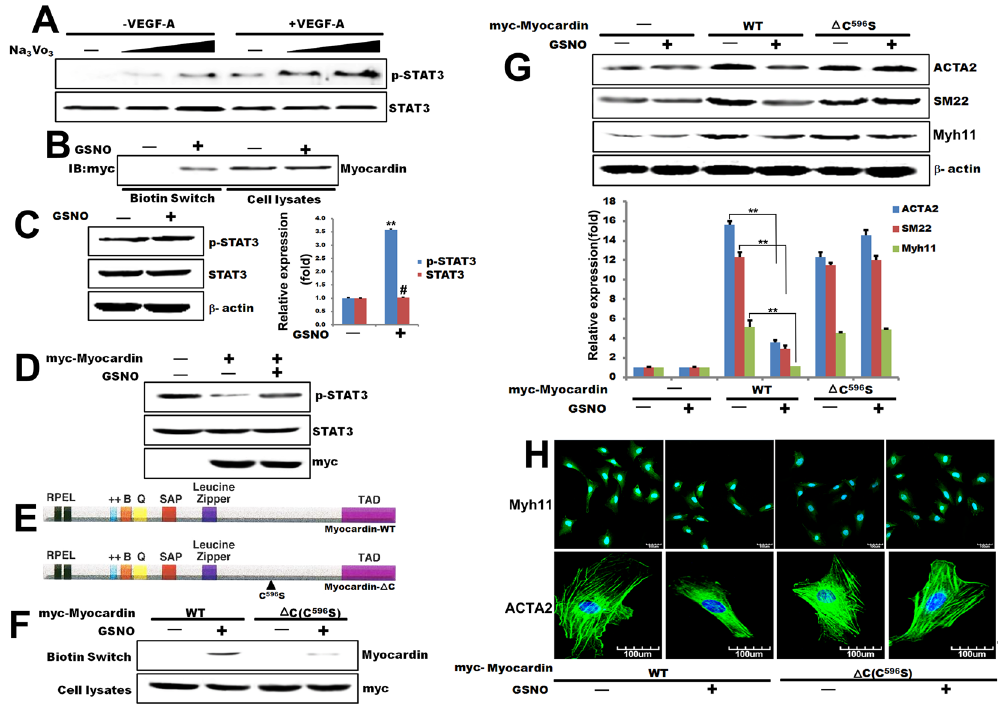
Figure 2. Myocardin is nitrosylated by nitric oxide. ( A ) Western blot analysis to detect phosphorylated STAT3 and total STAT3 protein in T/G HA-VSMC cells pretreated with Na3VO4 (10, 100, and 500 μ M) and then treated with 100 ng/mL VEGF-A for 48 hours. ( B ) Results of a biotin switch assay on HEK293T cells transfected with Myc-Myocardin and treated with the nitric oxide donor nitrosoglutathione (GSNO) (500 μ M) for 10 min at room temperature. ( C ) Western blot analysis to detect phosphorylated STAT3 and total STAT3 protein in T/G HA-VSMC cells pretreated with GSNO (500 μ M) for 10 min at room temperature and quantified the western blot data by Quantity One software. β -actin is a loading control. ** p < 0.01, # p > 0.05. n = 3. ( D ) Results of an in vitro phosphatase assay using active STAT3 protein as the substrate on lysates of HEK293T cells transfected with Myc-Myocardin. ( E ) Schematic structure of Myocardin mutant constructs. ( F ) Biotin switch analysis of HEK293T cells transfected with the indicated Myocardin-WT or Myocardin- Δ C and then treated with 50 μ M GSNO for 10 min at room temperature. ( G ) Western blot analysis of ACTA2, SM22 and Myh11protein level in T/G HA-VSMC cells transfected with Myocardin-WT or Myocardin- Δ C then treated with 200 μ M GSNO for 10 min and quantified the western blot data by Quantity One software. β -actin is a loading control. ** p < 0.01. n = 3. ( H ) Immunofluorescence technique of Myh11and ACTA2 protein level in T/G HA-VSMC cells transfected with Myocardin-WT or Myocardin- Δ C then treated with 200 μ M GSNO for 10